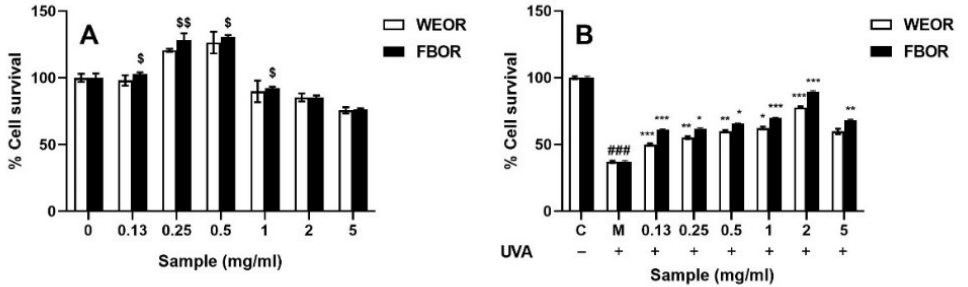
Figure 2. ( A ) Nontoxic concentrations of WEOR and FBOR-related cytotoxicity in HDF cells; ( B ) WEOR and FBOR prevent cytotoxicity in HDF cells exposed to UVA. (* p < 0.05, ** p < 0.01, *** p < 0.001, versus the UVB irradiation model group; ### p < 0.001, versus the control group. $ p < 0.05, $$ p < 0.01, the WEOR group versus the FBOR group. C: Control group; M: UVB irradiation model group).